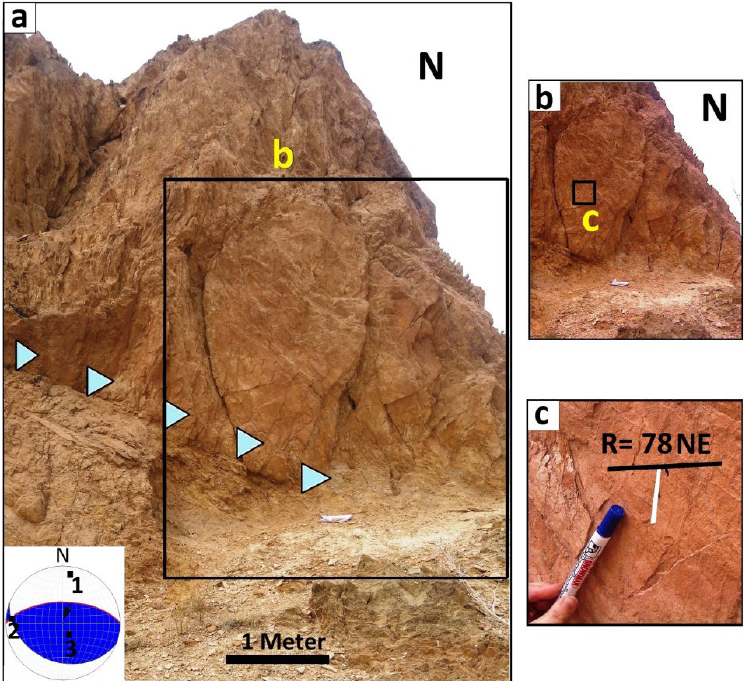
Figure 7. ( a ) Field photo illustrating the uplift in phyllite rocks by F3 fault (shown by triangles); ( b ) the trace of F3 fault with a closer view, which is a reverse fault with a sinistral component; ( c ) slicken line on the minor fault in part. Numbers 1, 2, and 3 in the stereonet denote the orientation of the principal stress axes; the arrow in the stereonet indicates the movement direction of the hanging wall.